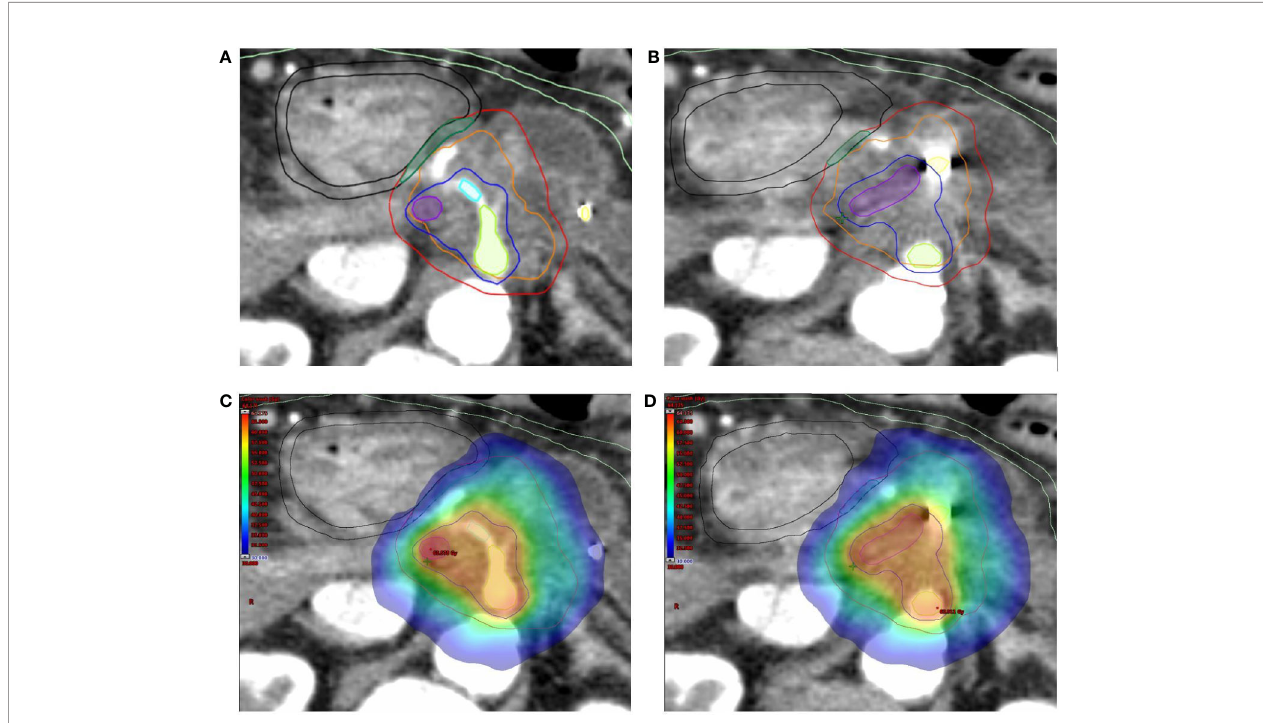
FIGURE 2 | (A, B) Target volumes delineation. The high-dose planning target volume (PTV sib , blue ) encompasses the tumor-vessel interface (celiac axis [ green ], common hepatic artery ( cyan ) and superior mesenteric-portal venous con fl uence [ violet ] + 3 mm expansion) inside the tumor planning target volume (PTV t , red ). Respect to organ at risk constraints is guaranteed by the simultaneous protection volume (PTV sip , dark green ). The following Organ at Risk (OARs) are shown: duodenum ( black ), and bowel ( light green ), as well as the fi ducial markers ( yellow ). The Planning at Risk Volume (PRV oars ) are generated by 3 mm expansion from corresponding OARs (shown with same color on axial images). (C, D) Typical dose distribution (color wash) for SBRT plan with Simultaneous Integrated Boost (SIB) and Simultaneous Integrated Protection (SIP). The prescription dose is 60/40/33 Gy in 5 daily fractions to PTV sib /PTV t /PTV sip , respectively. The sample plan demonstrates excellent PTVs coverage with appropriate respect of